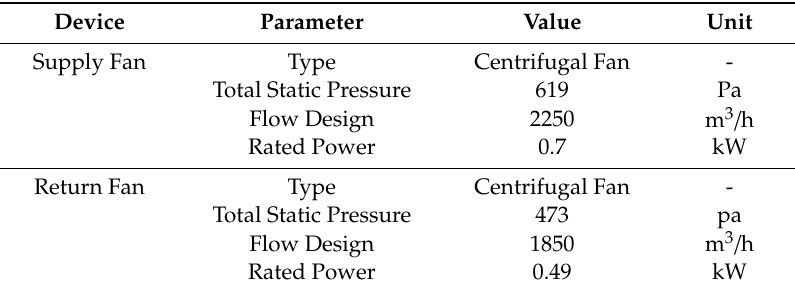
Table 2. Technical data for the supply and return fan.